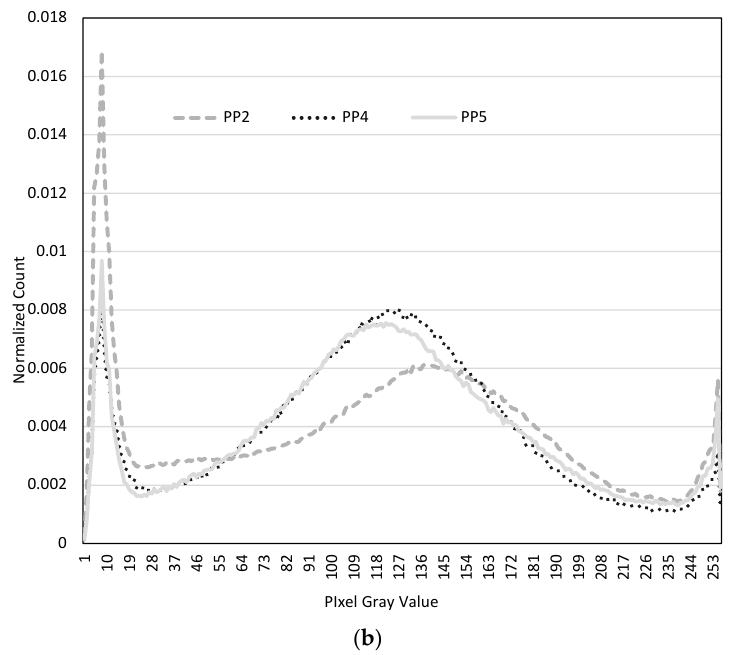
Figure 7. Relationship between inverse of the histogram mean image intensity and the measured surface infiltration rate for (a) locations 1 to 3, and (b) locations 2, 4 and 5 on the Porous Pave site as a normalized pixel count for each gray level when the statistic is the mean or the median. The number after the symbol PP in the legend corresponds to the location on the Porous Pave site.